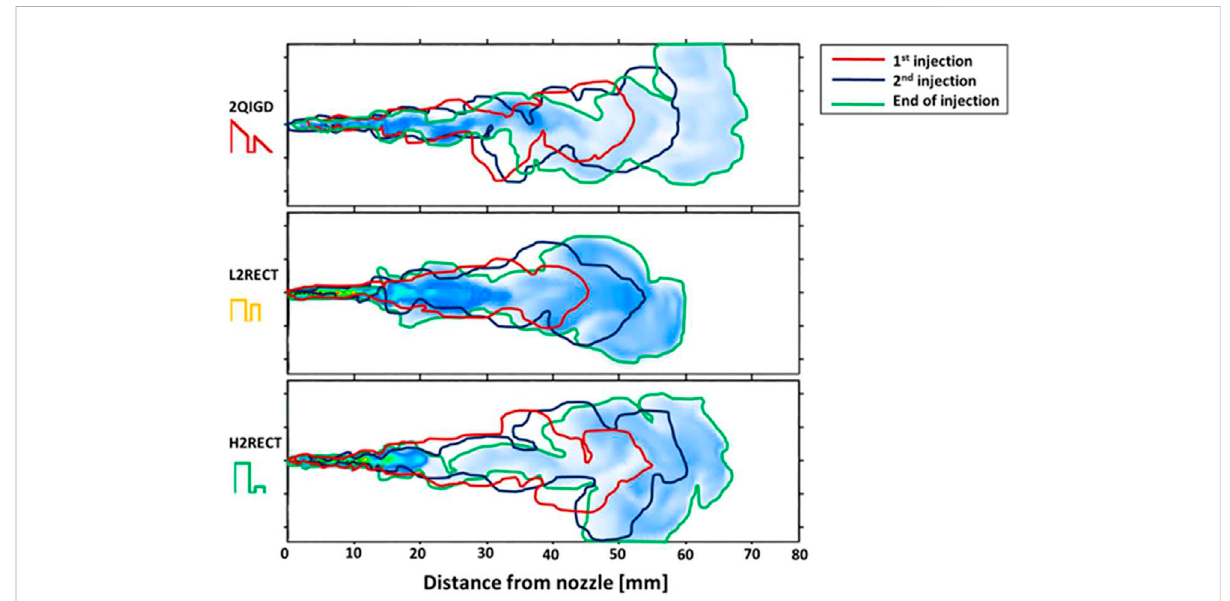
FIGURE 15 Spray area boundary for different spraying ranges. The fi rst injection boundary is shown at the end of the fi rst injection. The second injection boundary is shown at the beginning of the second injection. The end of the injection boundary is shown at the end of the injection point, which is different in each case.